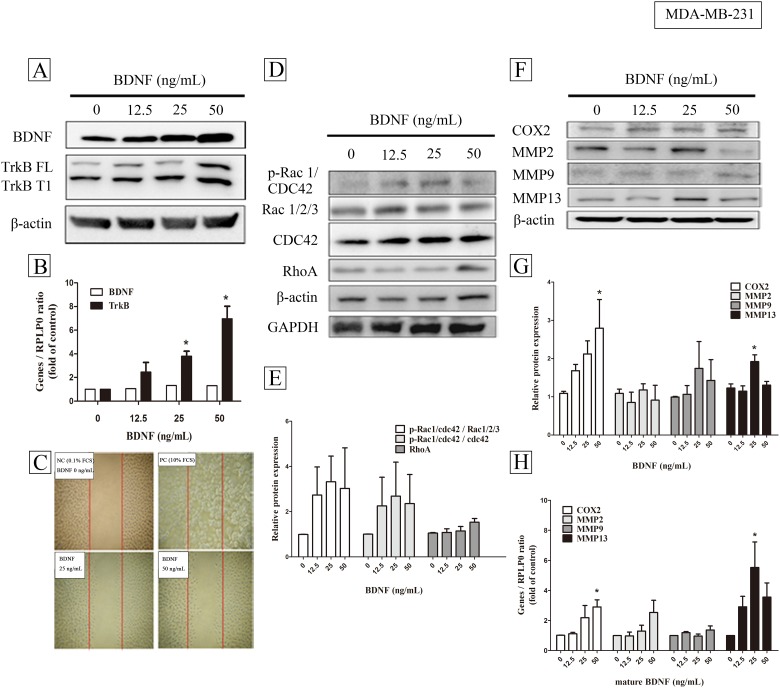
The effects of brain-derived neurotrophic factor (BDNF) on autoregulation, migration and migration related proteins signaling in MDA-MB-231 cells.MDA-MB-231 (4 X105 / well) cells cultured with low serum medium were treated with BDNF (0-, 12,5-, 25-, and 50 ng/mL) for 24 h or 6 h, and analyzed with Western blot (A) or real-time PCR (B), respectively. TkrB FL and TrkB T1 indicated full length and T1 domain of TrkB, respectively. Cells at a density of 2×104 cells were seeded into a 3.5 cm Petri dish containing an insert for migration assay (C) as described in Methods. Protein expressions of Rac, CDC42, and Rho (D) were quantified (E) and gene expression of COX2, MMP2, MMP9, and MMP13 were analyzed with Western blot (F,G) and real-time PCR (H). Data were expressed as mean + SEM. *, p< 0.05 compared to vehicle group by one way ANOVA, n = 4–5).